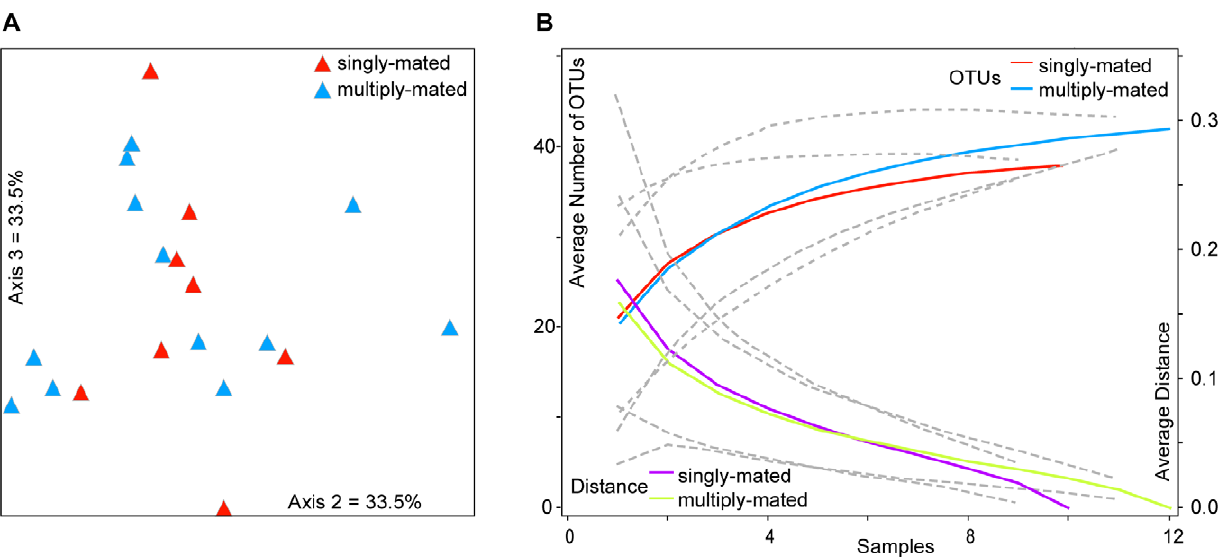
Figure 2. Analyses comparing microbiota between colonies with singly mated and multiply mated queens. (A) NMS ordination plot showing the two axes representing most of the variation among honey bee gut communities (N=20). Samples S5 and S7 were omitted as outliers. (B) Species accumulation curves for the two treatments. Dotted lines indicate confidence intervals ( 6 2 SD) for species and distance curves.